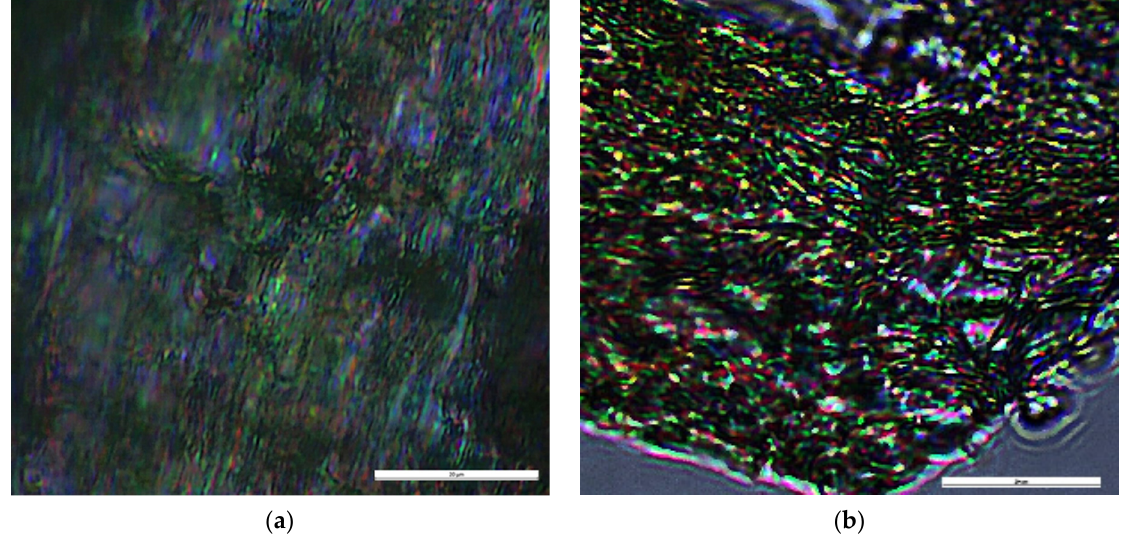
Figure 4. Images of the hydrogel under polarized light (scale bar: 20 μ m), acquired on ( a ) thick and ( b ) thin sample of hydrogel.